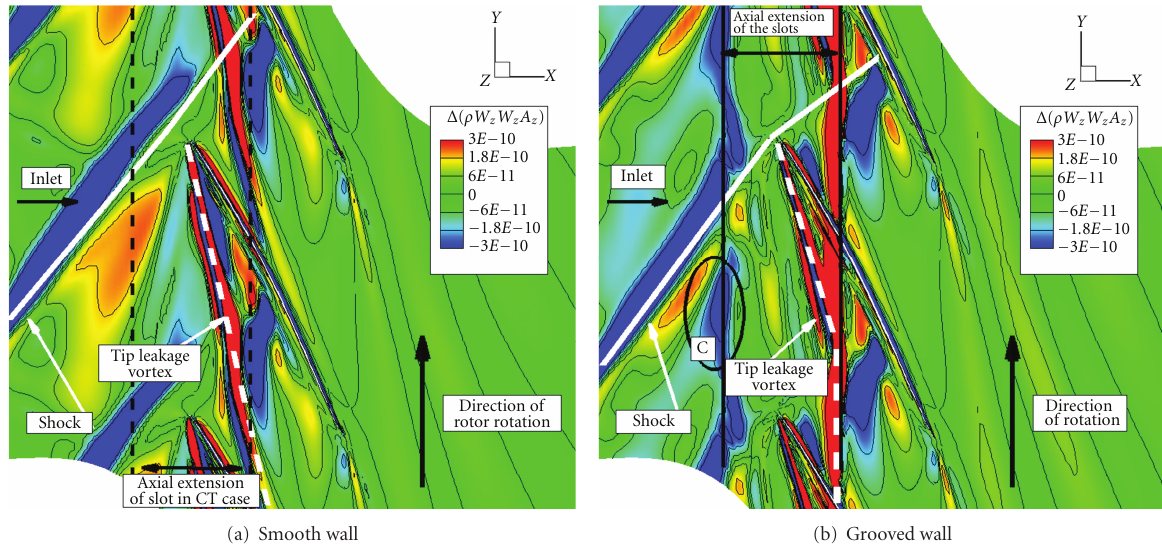
Figure 20: CBUAA: Flow field denoted at midgap by negative values of Δ ( ρW z 2 A z